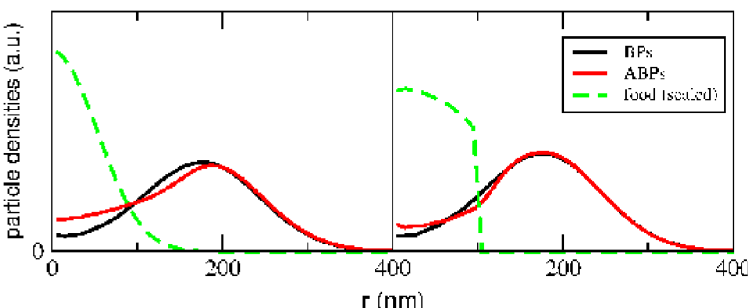
Fig 6. Transient density distributions. Time evolution of the density distributions of BPs (black) and ABPs (red), as well as food-particles (green, scaled down), averaged over the time interval of 0.1 < t < 0.15ms. Initial distance of the particles to the food source: r ini = 200nm. Left panel: initial food profile was Gaussian, right panel: Initial food profile was a step-function. We remind that, despite the food being immobile, their profiles are depleted by the particles.